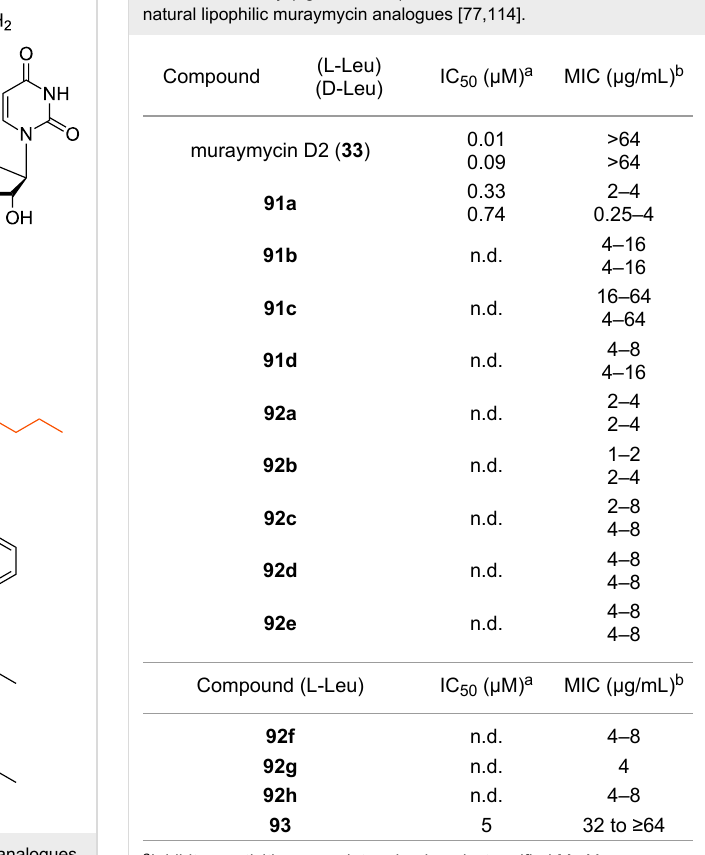
dine (L-Cpm, 92a ), L-arginine (L-Arg, 92b ) and L-ornithine (L-Orn, 92c ) in order to investigate the role of the cyclic guani- dine functionality (Figure 10) [77].